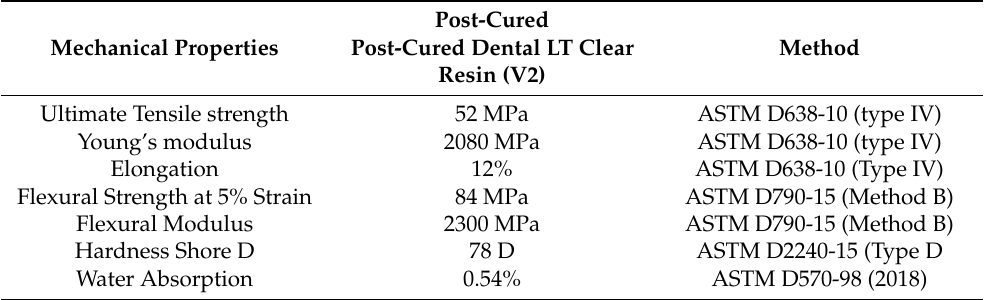
Table 1. Material properties of LF Dental clear